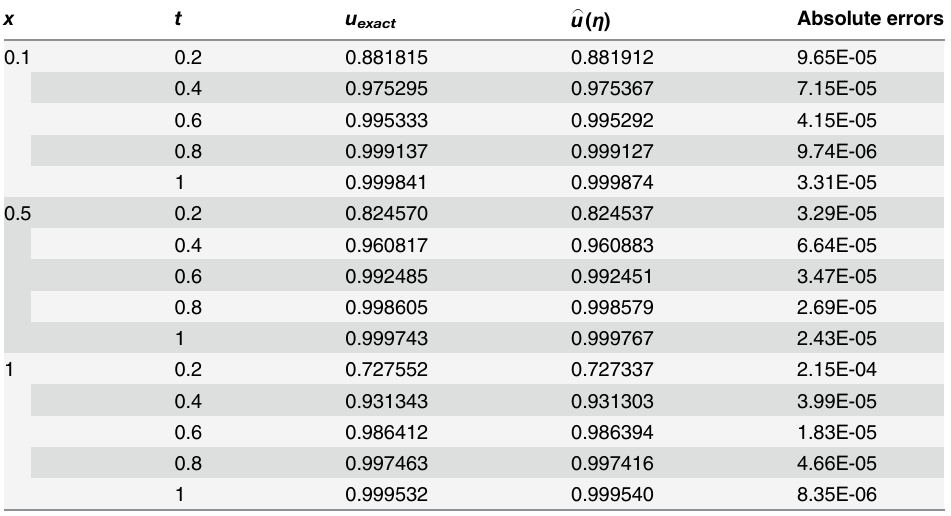
Table 5. Comparison of numerical solutions and absolute errors for α = 2, β = 5, δ = 3/2. x t u